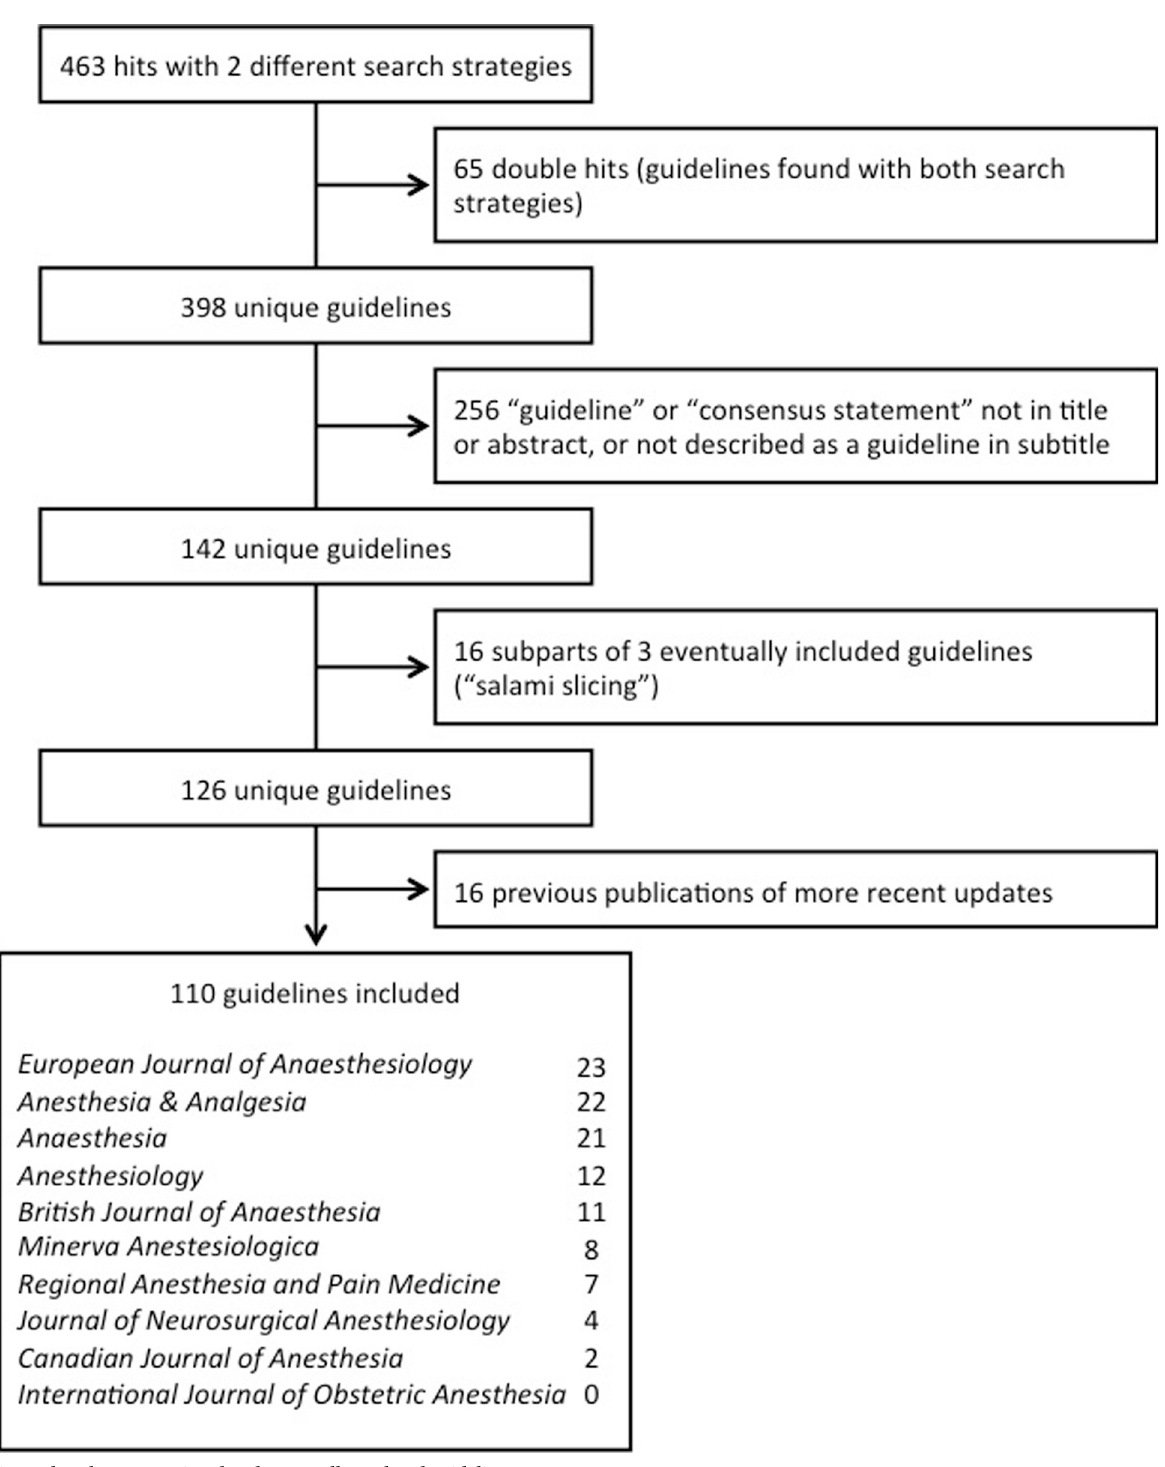
PLOS ONE | https://doi.org/10.1371/journal.pone.0212327 February 27,